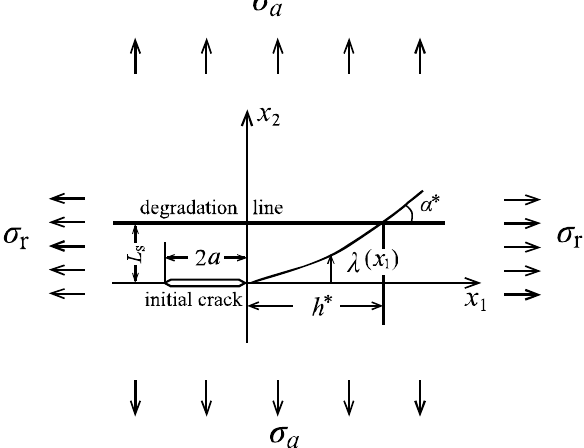
Figure 10: A mathematical modeling of curved crack propagation along butt-weld.